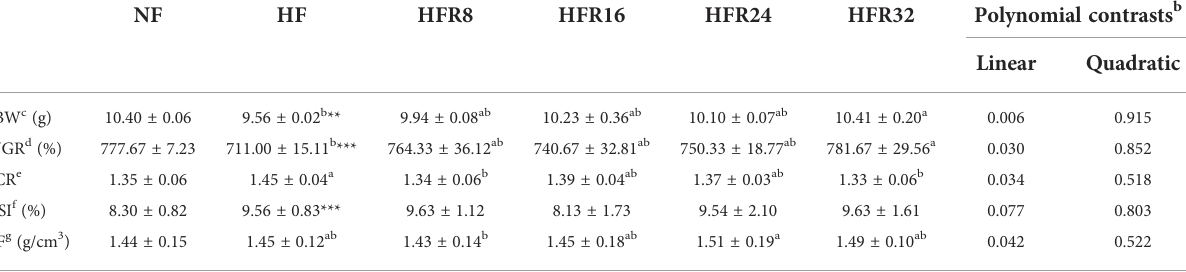
TABLE 3 Effects of resveratrol supplementation on the growth performance in common carp ( Cyprinus carpio ) a